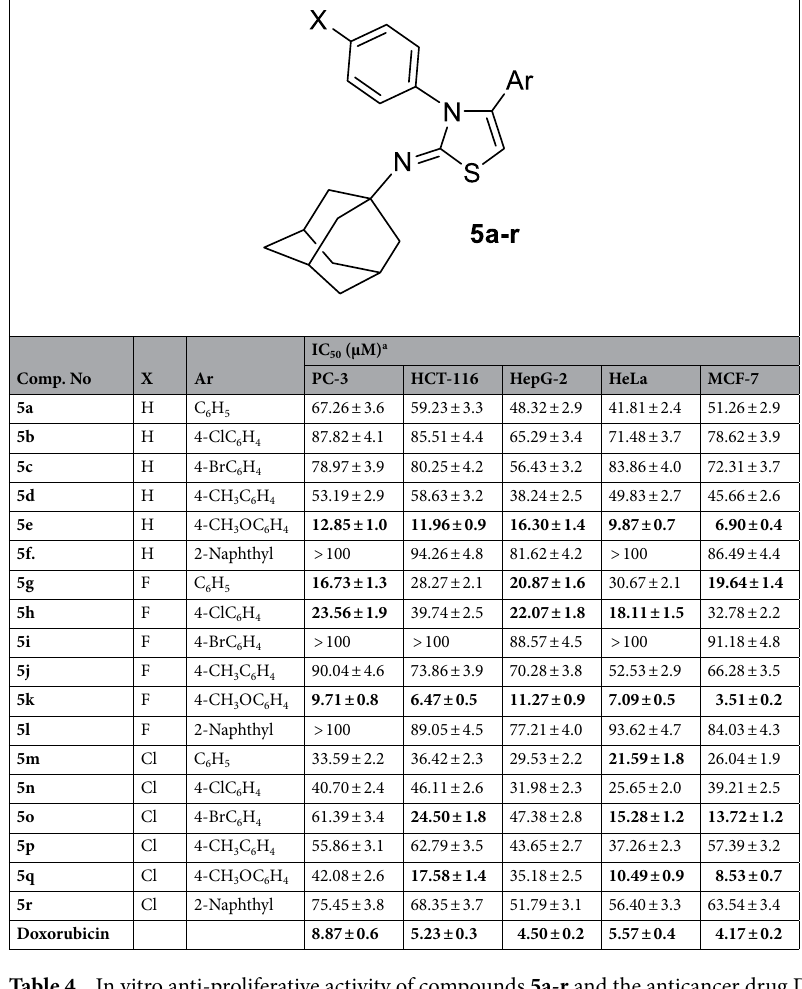
Table 4. In vitro anti-proliferative activity of compounds 5a-r and the anticancer drug Doxorubicin toward human prostate cancer (PC-3), colorectal carcinoma (HCT-116), hepatocellular carcinoma (HepG-2), epithelioid cervical carcinoma (HeLa) and mammary gland breast cancer (MCF-7) cell lines. a IC 50 Values presented as the mean ± SD of three separate determinations. Significant values are in